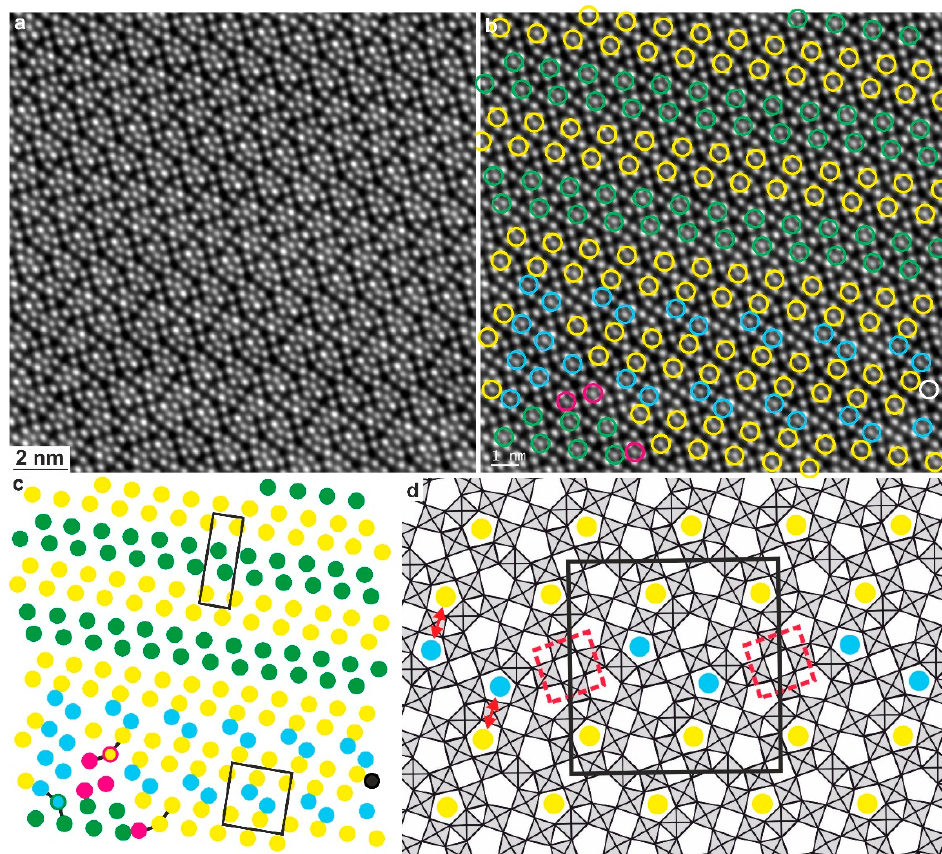
Figure 2. ( a ) HAADF-STEM image of Nb 18 W 16 O 93 recorded along [001] (courtesy of Prof. L. Shen, Nanjing) and ( b ) with the filled PTs marked as open circles. Pairs of diamond-linked pentagonal columns (PC) with the same orientation have the same color. ( c ) Scheme of the PCs with unit cells of Nb 8 W 9 O 47 (top) and Nb 12 W 11 O 63 (bottom) outlined. ( d ) Structural model of Nb 12 W 11 O 63 . Red double arrows mark two directly adjacent PCs, and dashed squares mark empty TTB units. For details, see text. Figure 2a has been published in modified form as Figure 2e in [12] under CC-BY license.